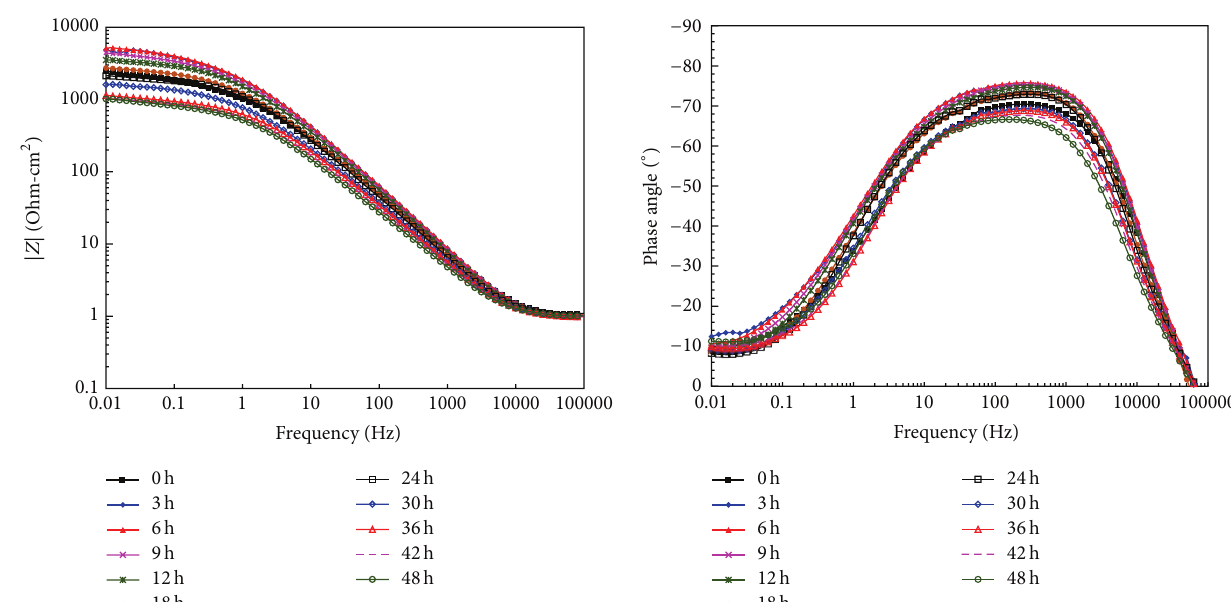
Figure 6: Bode plots for copper in 1.0 M H 2 SO 4 solution at 25 ∘